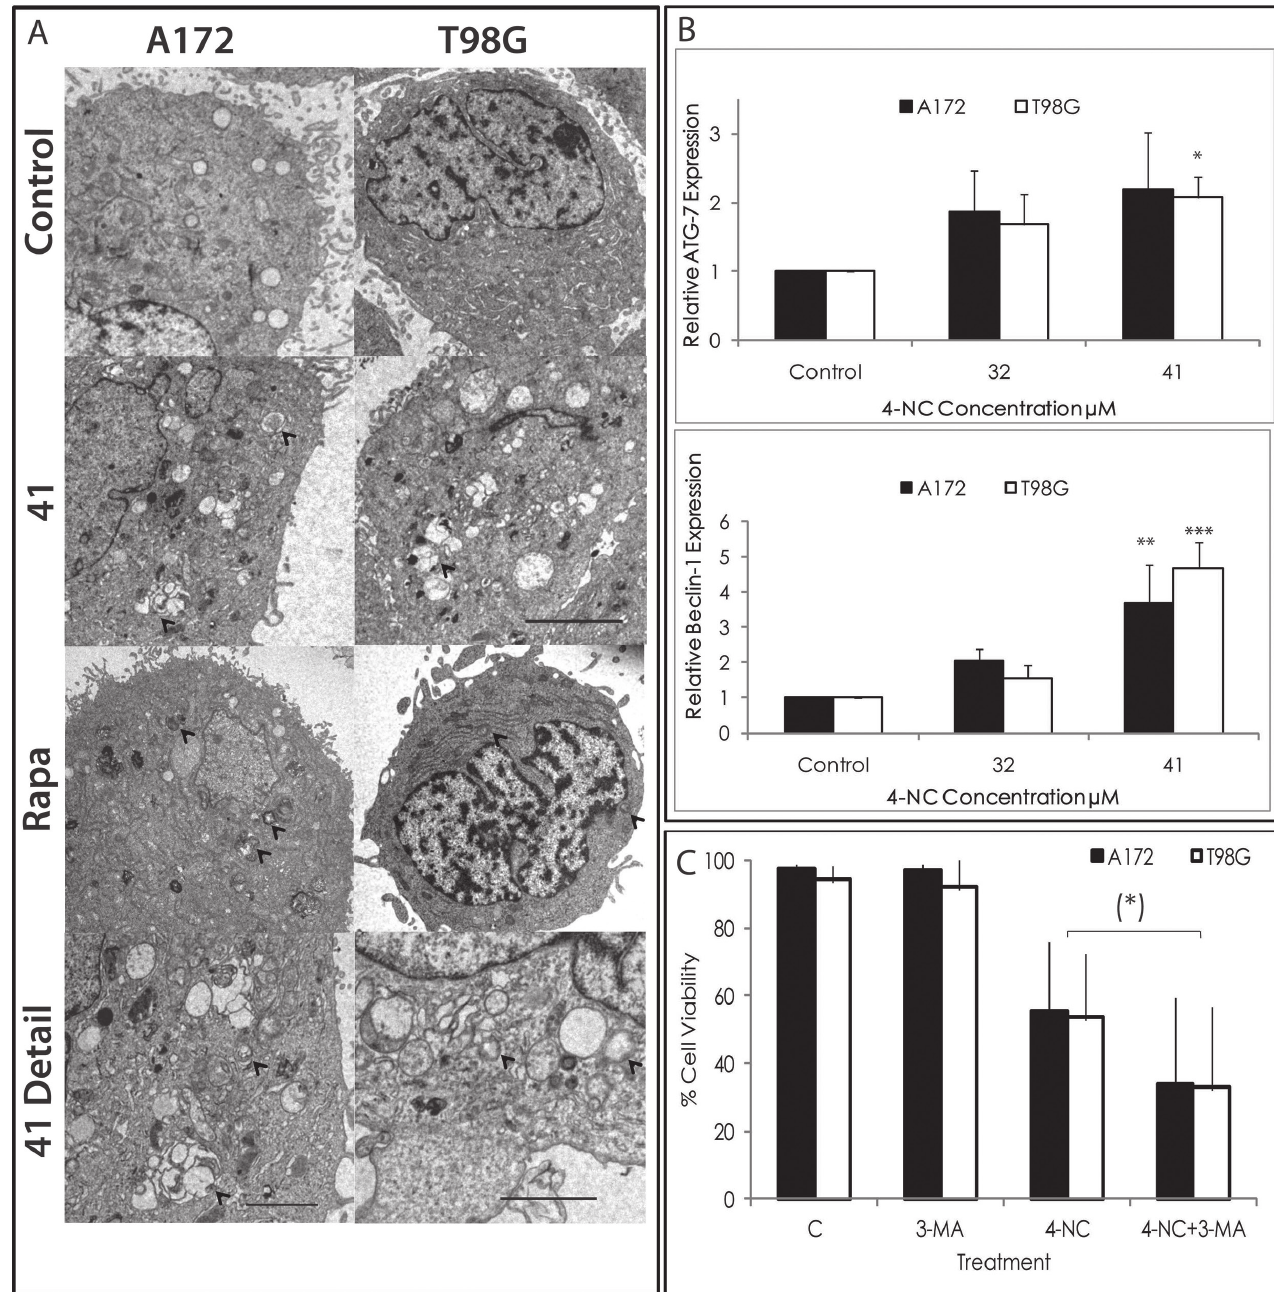
FIGURE 3 - Effect of 4-NC on autophagy